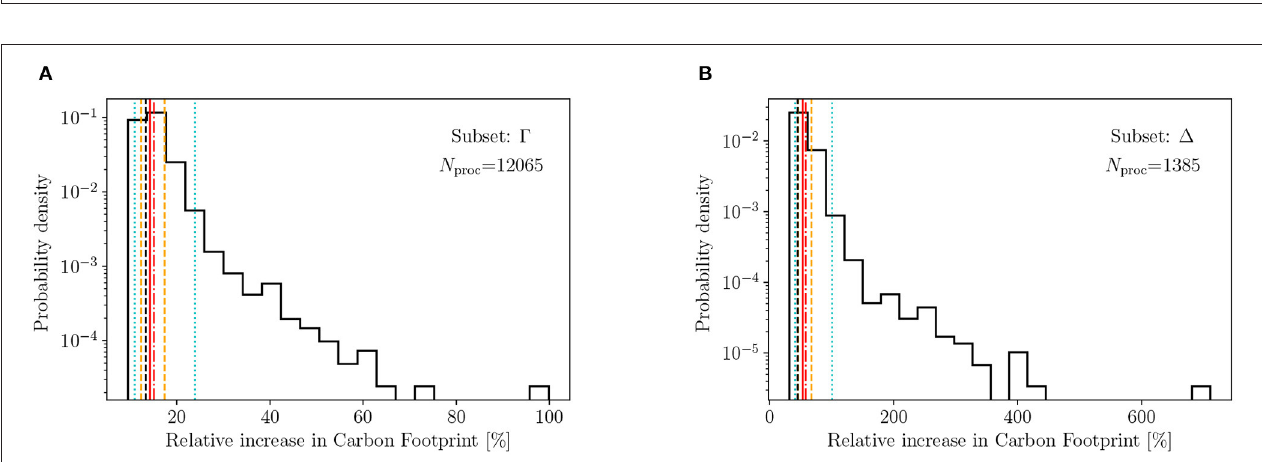
FIGURE 3 | The uncertainty distribution of the relative increase in carbon footprint (GWP100) due to hybridisation, using the STAM double counting correction method, for the overall hybrid footprint (A) and the 1,385 processes with a price sampling variance from the BACI trade data based on produced commodity and region (B) . The dotted (cyan) and dashed (orange) vertical lines indicate the 95 and 68% confidence intervals, the red solid and dashed dotted lines show the median and mean of the distribution. The black dashed line indicates the impact using the ecoinvent prices.